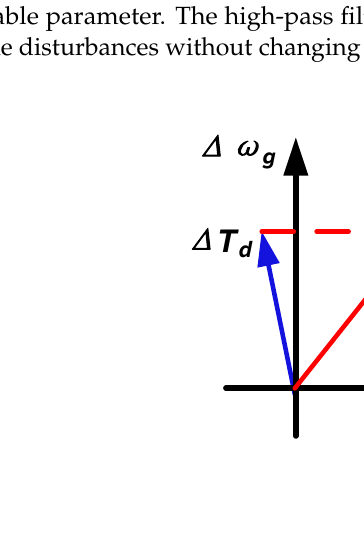
( b ) Figure 6. The dynamics of synchronverter internal voltage under two special circumstances: ( a ) neg- ative damping torque; ( b ) negative synchronizing torque.